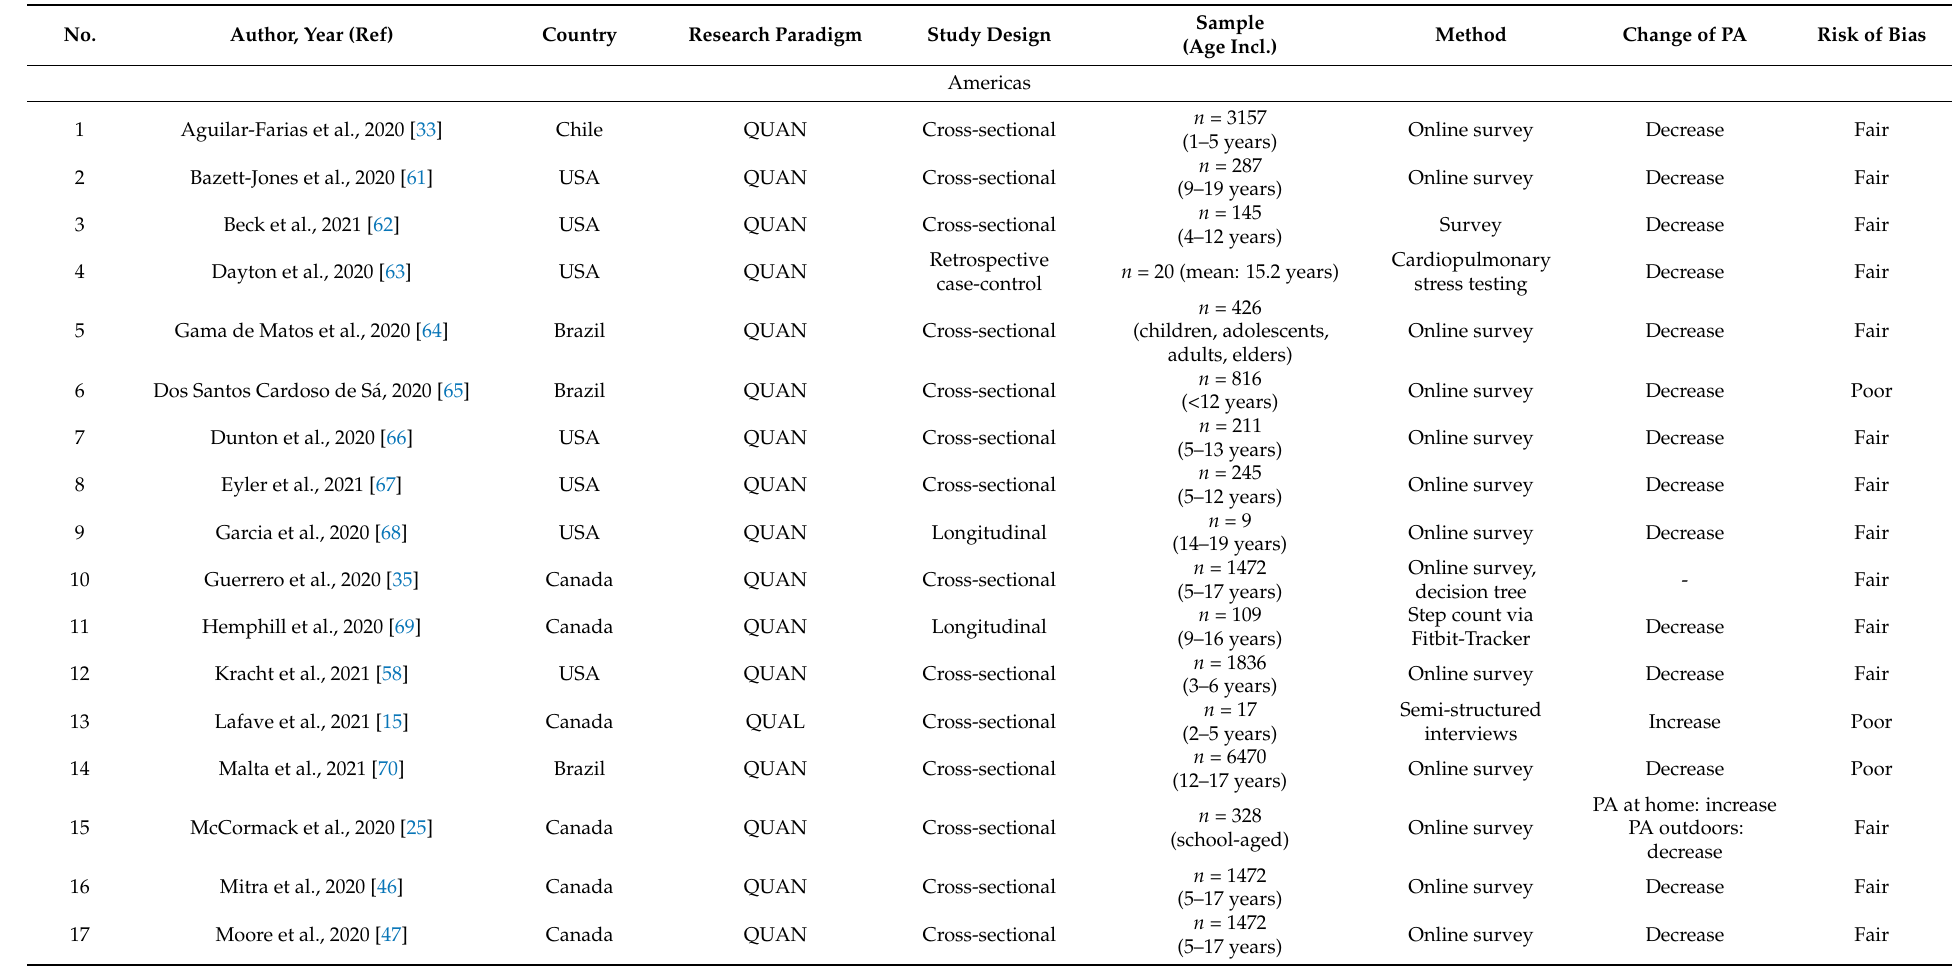
Table A1. Overview of studies included in the systematic review by continent (in alphabetic